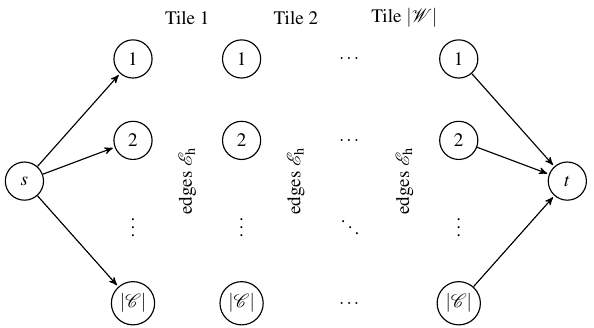
Figure 7. Transducer-based directed acyclic graph for generation of valid row